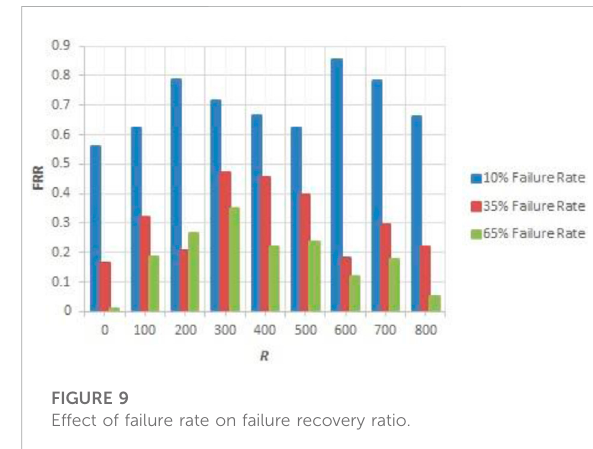
FIGURE 8 Effect of failure rate on failure detection ratio.